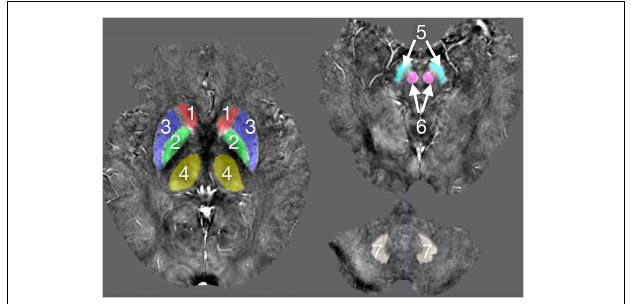
FIGURE 1 | The deep gray matter nuclei of interest outlined in the QSM images.1, CN; 2, GP; 3, PUT, 4, THA; 5, SN; 6, RN; and 7, DN.